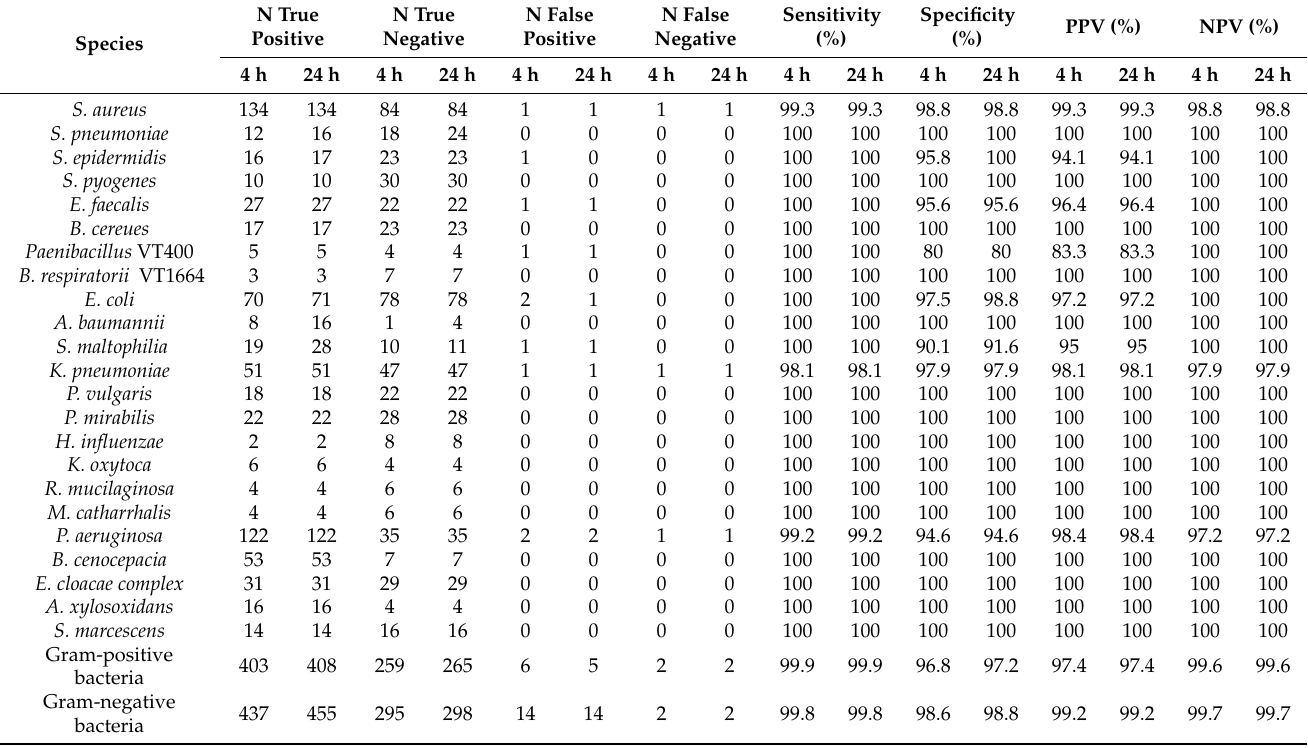
Table 2. Overall identification performance of the AtbFinder system after 4 and 24 h of culturing. N True Species